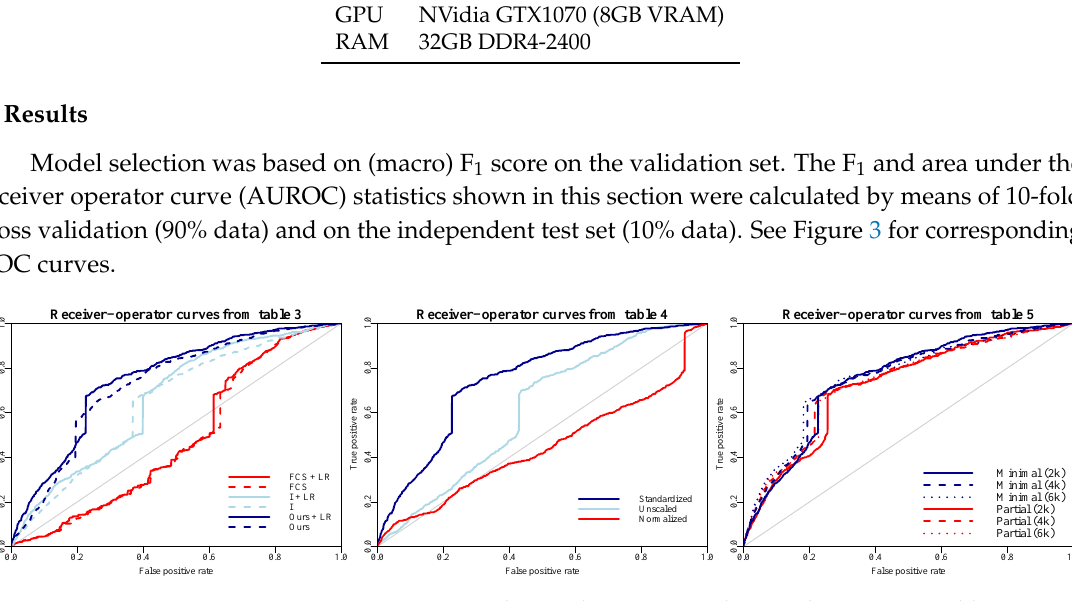
Figure 3. Receiver operator curves corresponding to the AUROC values on the test set in Table